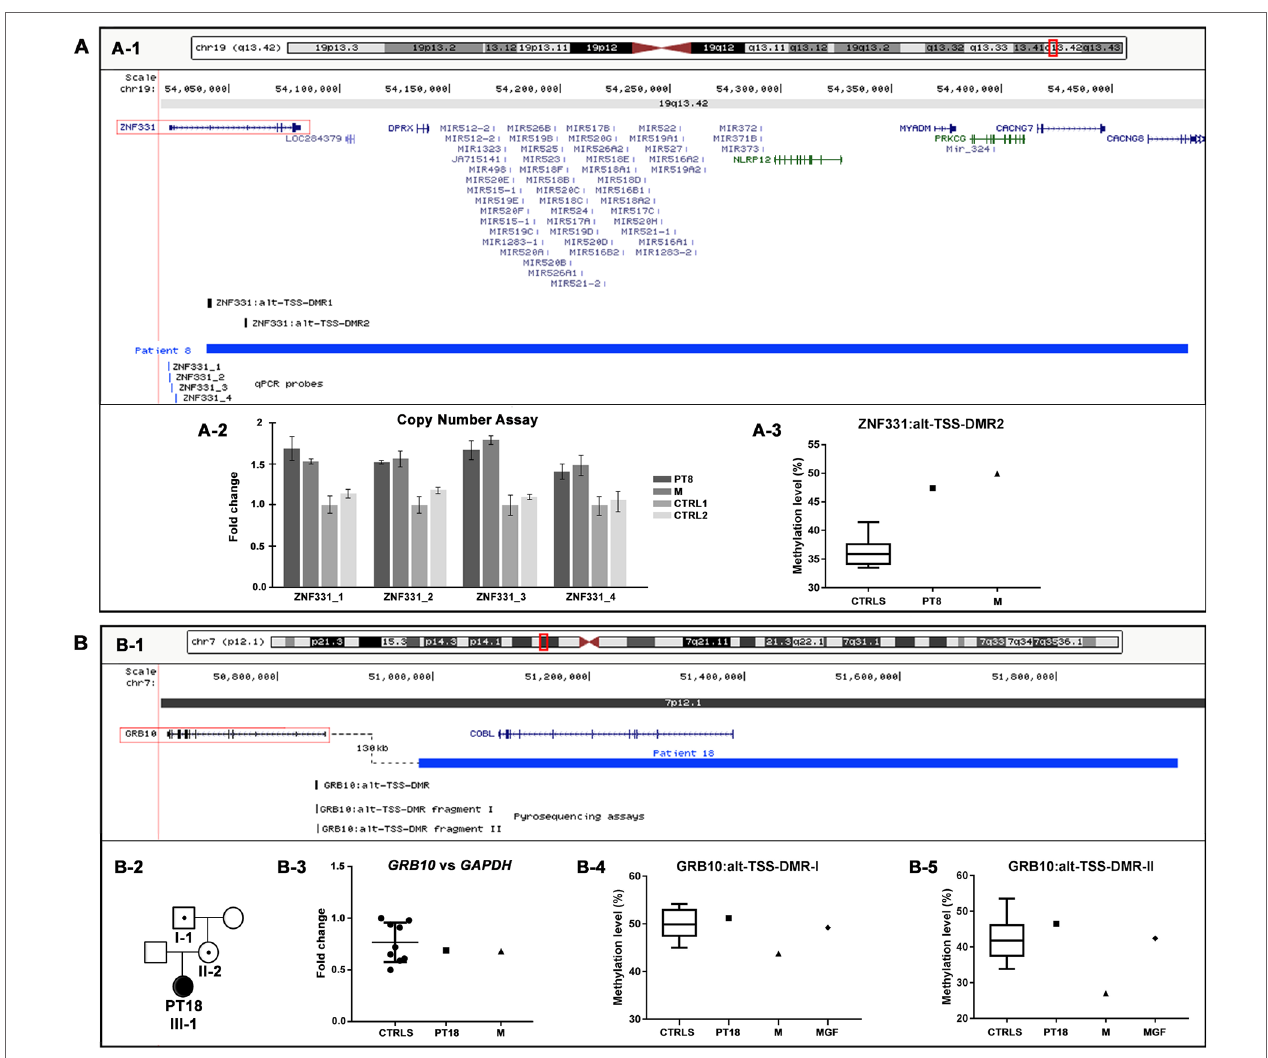
FIGURE 3 | Physical map of the genomic regions and molecular characterization of the potentially pathogenic CNVs identified by array CGH. The 19q13.42 (A-1) and 7p12.1 (B-1) regions showing in blue the duplication identified in patients 8 (A-1) and 18 (B-1) . The RefSeq genes are depicted in dark blue, and the OMIM disease genes in green; the candidate genes are illustrated by red boxes, and the differentially methylated regions (DMRs) in black. The positions of pyrosequencing assays and qPCR probes used in the CNVs’ molecular characterization are reported in black and blue, respectively. The images are a modification of a version obtained from the UCSC Genome Browser (human genome assembly GRCh37/hg19). (A-2) Copy number analysis by using qPCR probes specific for ZNF331 gene promoter confirmed the entire duplication of ZNF331 gene in both patient 8 and her mother (M). (A-3) Pyrosequencing analysis performed on blood DNA of the ZNF331:alt- TSS-DMR2 showed an hypermethylation level in both patient 8 and her mother (M) compared with healthy controls. (B-2) Patient 18’s family tree showing duplication transmission. (B-3) Relative expression of GRB10 blood mRNA in patient 18 and her mother (M), compared with healthy controls. Data were normalized against GAPDH as housekeeping gene; similar results were obtained using TBP , HMBS , and RPLP0 as normalizer (data not shown). (B - 4 , B - 5) Pyrosequencing analysis of the GRB10:alt-TSS-DMR performed on blood DNA showed a methylation level in patient 18 and her maternal grandfather (MGF) compared with healthy controls with both assays, while in patient 18’s mother (M), a hypomethylation level was detected with both assays. CNVs, copy number variants; CGH, comparative genomic hybridization; OMIM, Online Mendelian Inheritance in Man; qPCR, quantitative polymerase chain reaction; UCSC, University of California Santa